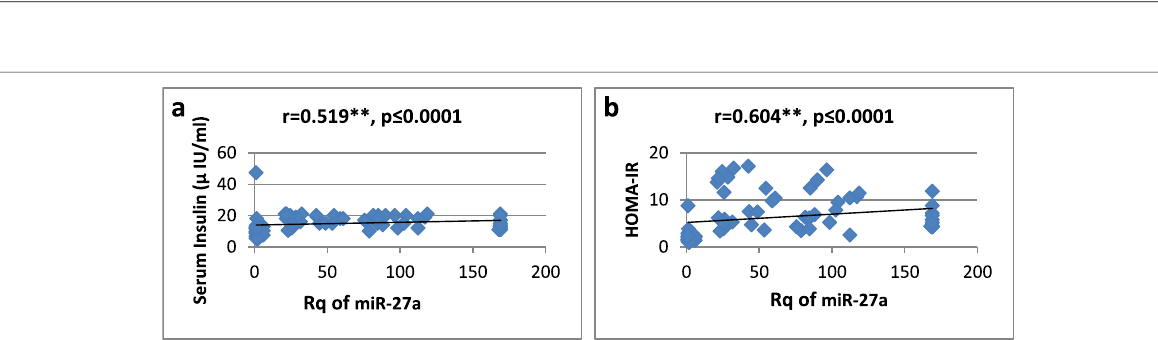
0.519) and HOMA‑IR ( r 0.604), where “**” means = =